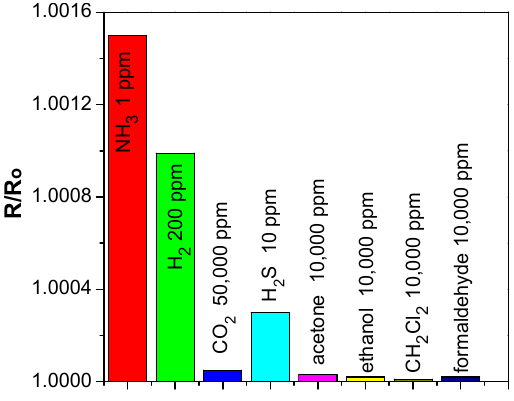
Figure 10. Sensor response of SWCNT/SiPc hybrid layers to different analytes.